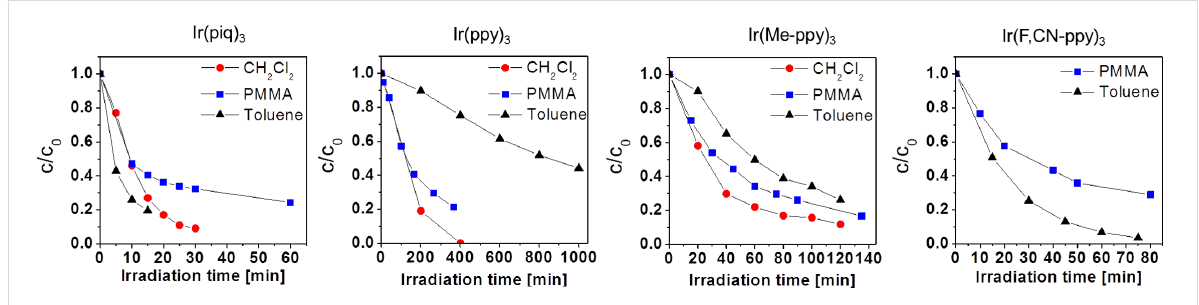
Figure 3: Photodegradation behavior of the iridium complexes in CH 2 Cl 2 and toluene solution and in a spin-coated PMMA polymer film under ambient conditions. For measurements that were performed repeatedly, the depicted values represent the mean of all experiments.